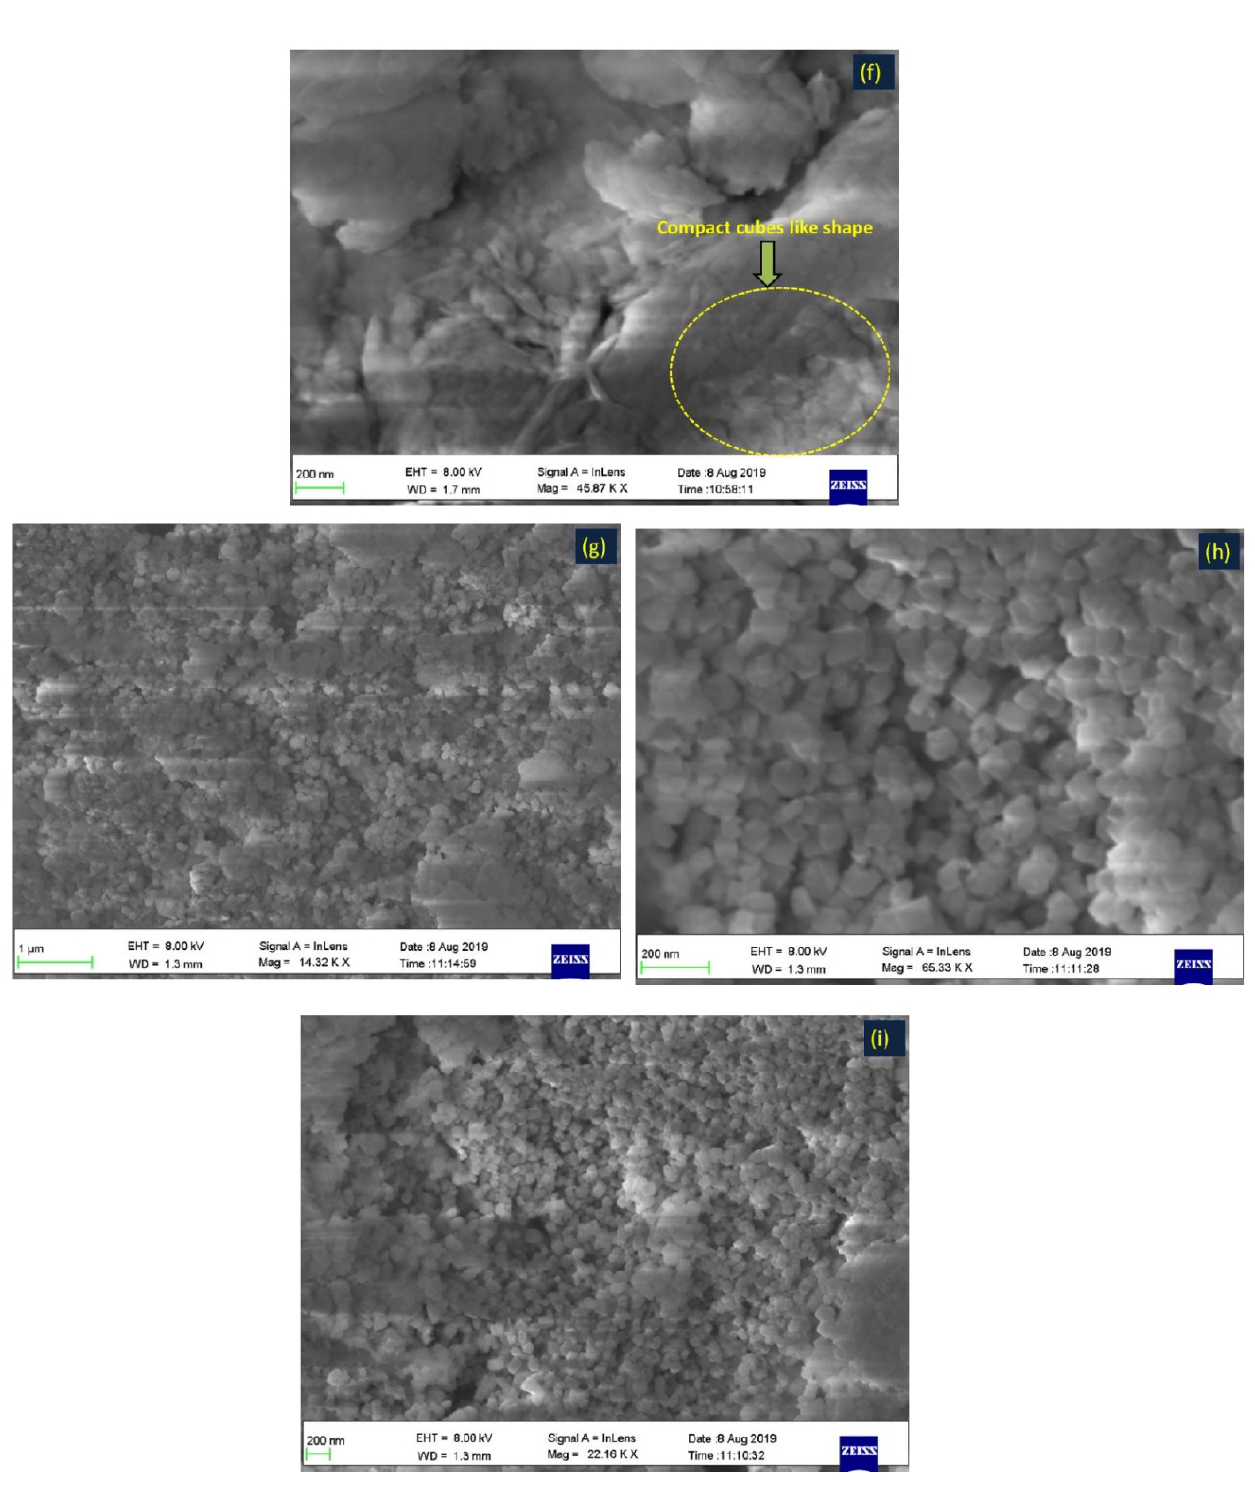
Figure 4. FESEM images of the prepared Zn-Fe LDH ( a – c ), zeolite ( d – f ) and zeolite/Zn-Fe LDH ( g – i ).